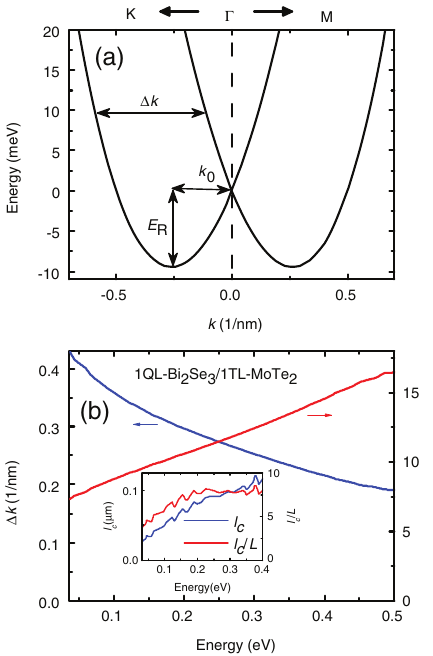
Fig. 3 a The zoom-in of the electronic structure of the 1QL-Bi 2 Se 3 / 1TL-MoTe 2 heterostructure near the Γ point. The Rashba energy E R , the wave number offset k 0 , and the WND between the two RBs Δ k Fig. 4 a Spin texture of the 1QL-Bi 2 Se 3 /1TL-MoTe 2 heterostructure. are indicated. b The WND between the two RBs Δ k and the The in-plane spin-polarization directions S || are indicated by the corresponding spin precession length L as functions of energy. The arrows . The out-of-plane spin polarizations S ⊥ are represented by the l inset shows the coherence length l color of the arrows . b The azimuthal average of the magnitude of the c and the ratio of the c to the spin precession length as functions of energy spin polarization. The blue ( red ) lines are those of the inner ( outer ) Rashba branch, and the solid ( dashed ) lines are those of the in-plane (out-of-plane) component. The maximum and minimum magni- tudes of the in-plane spin polarization are indicated by the dotted